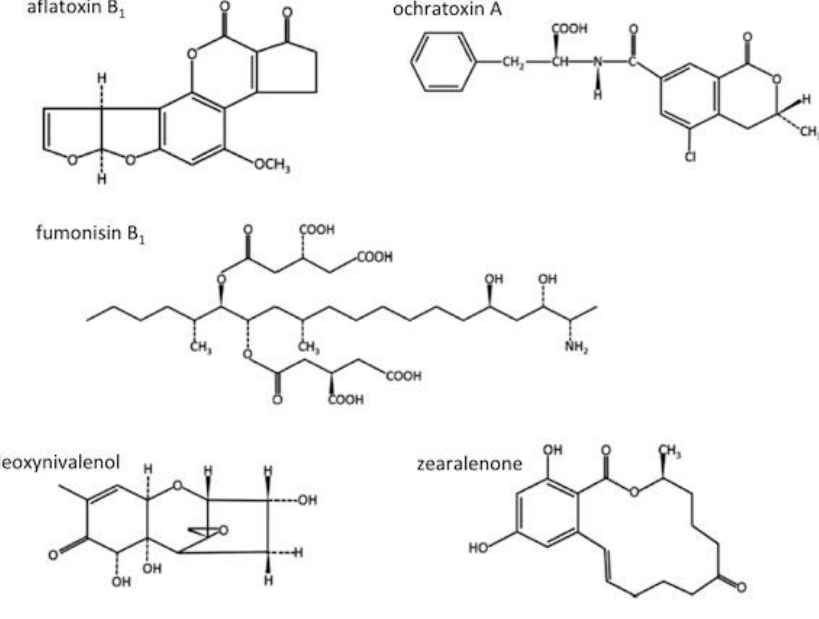
Figure 2. Mycotoxins in cereal grains, modified from F igure 2 Mycotoxins in cereal grains, modified from [31].